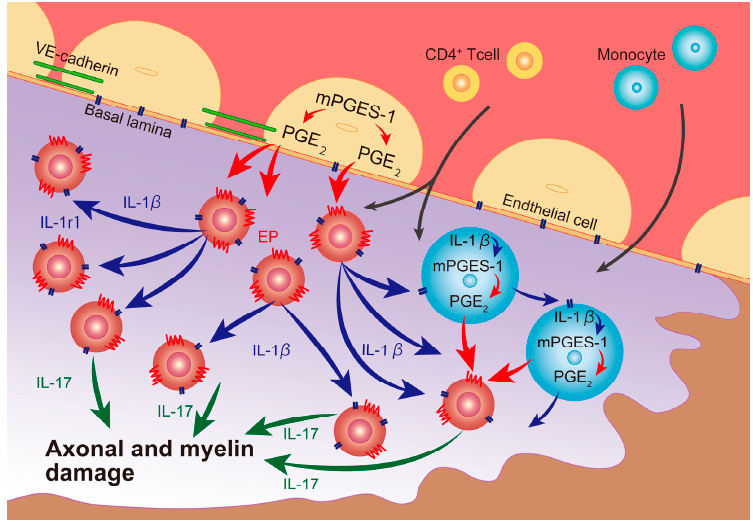
Scheme 1. PGE 2 synthesized by mPGES-1 facilitates the invasion of CD4 + T cells by inducing EP and IL-1r1 receptors, and potentiates IL-1 β production, which exerts an autocrine signaling through IL-1r1 in wt EAE mice. This intercellular interaction affects IL-17 production, which finally aggravates inflammation and demyelination. Red arrows show production and secretion of PGE 2 , blue arrows show IL-1 β , green arrows show IL-17, and gray arrows show cells infiltration from blood to spinal cord.